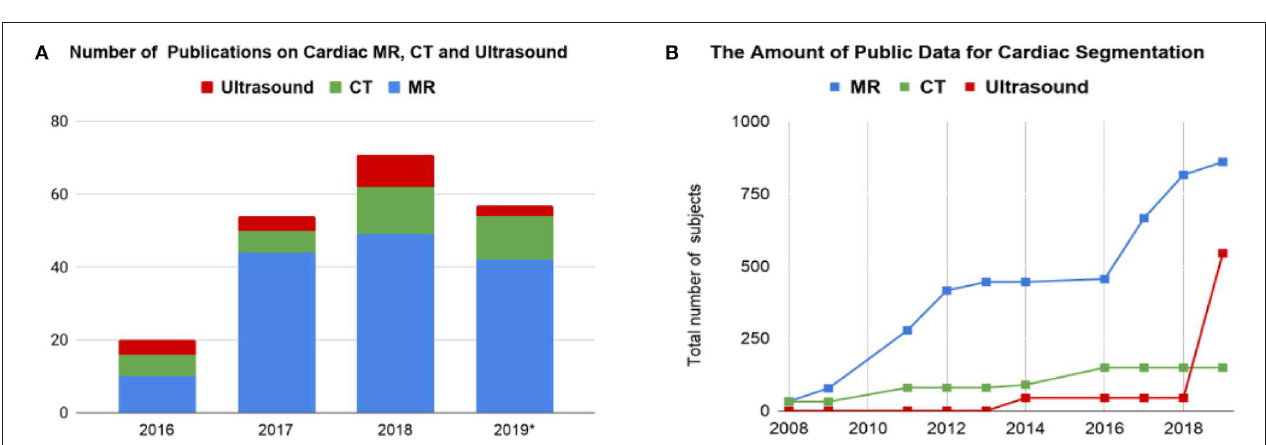
FIGURE 2 | (A) Overview of numbers of papers published from 1st January 2016 to 1st August 2019 regarding deep learning-based methods for cardiac image segmentation reviewed in this work. (B) The increase of public data for cardiac image segmentation in the past 10 years. A list of publicly available datasets with detailed information is provided in Table 6 . CT, computed tomography; MR, magnetic